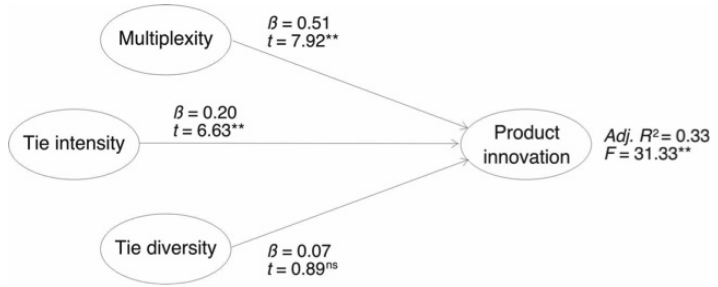
Fig. 3. Results of the analysis of the first